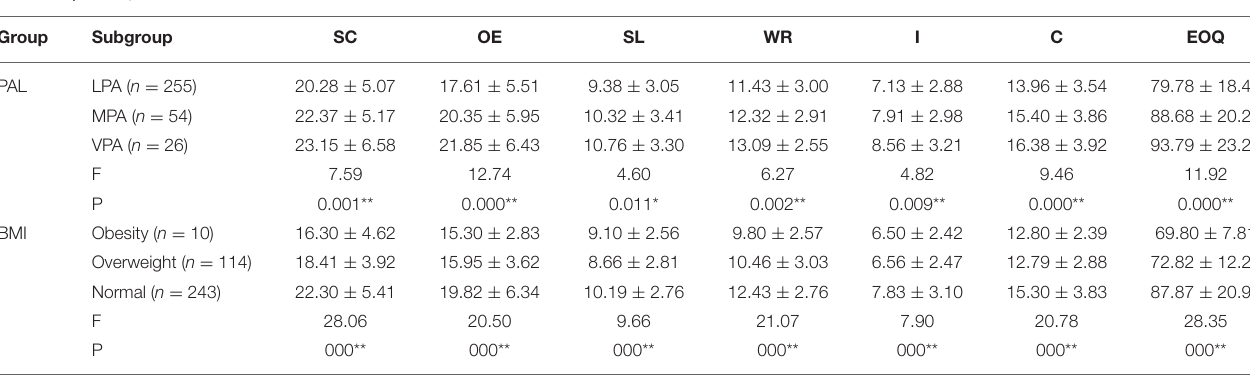
TABLE 9 | Descriptive of mean scores of different PAL and BMI values.